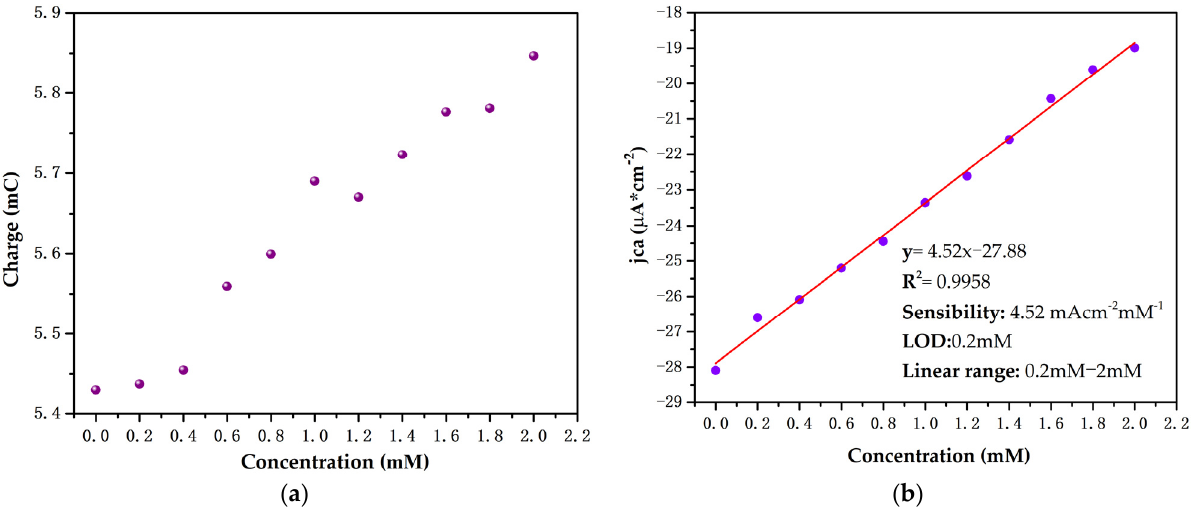
Figure 9. ( a ) Calculated charge accumulated on the electrode surface during reduction process. ( b ) Determination of sensitivity and limit of detection (LOD) of the synthesized electrode at 330 s.